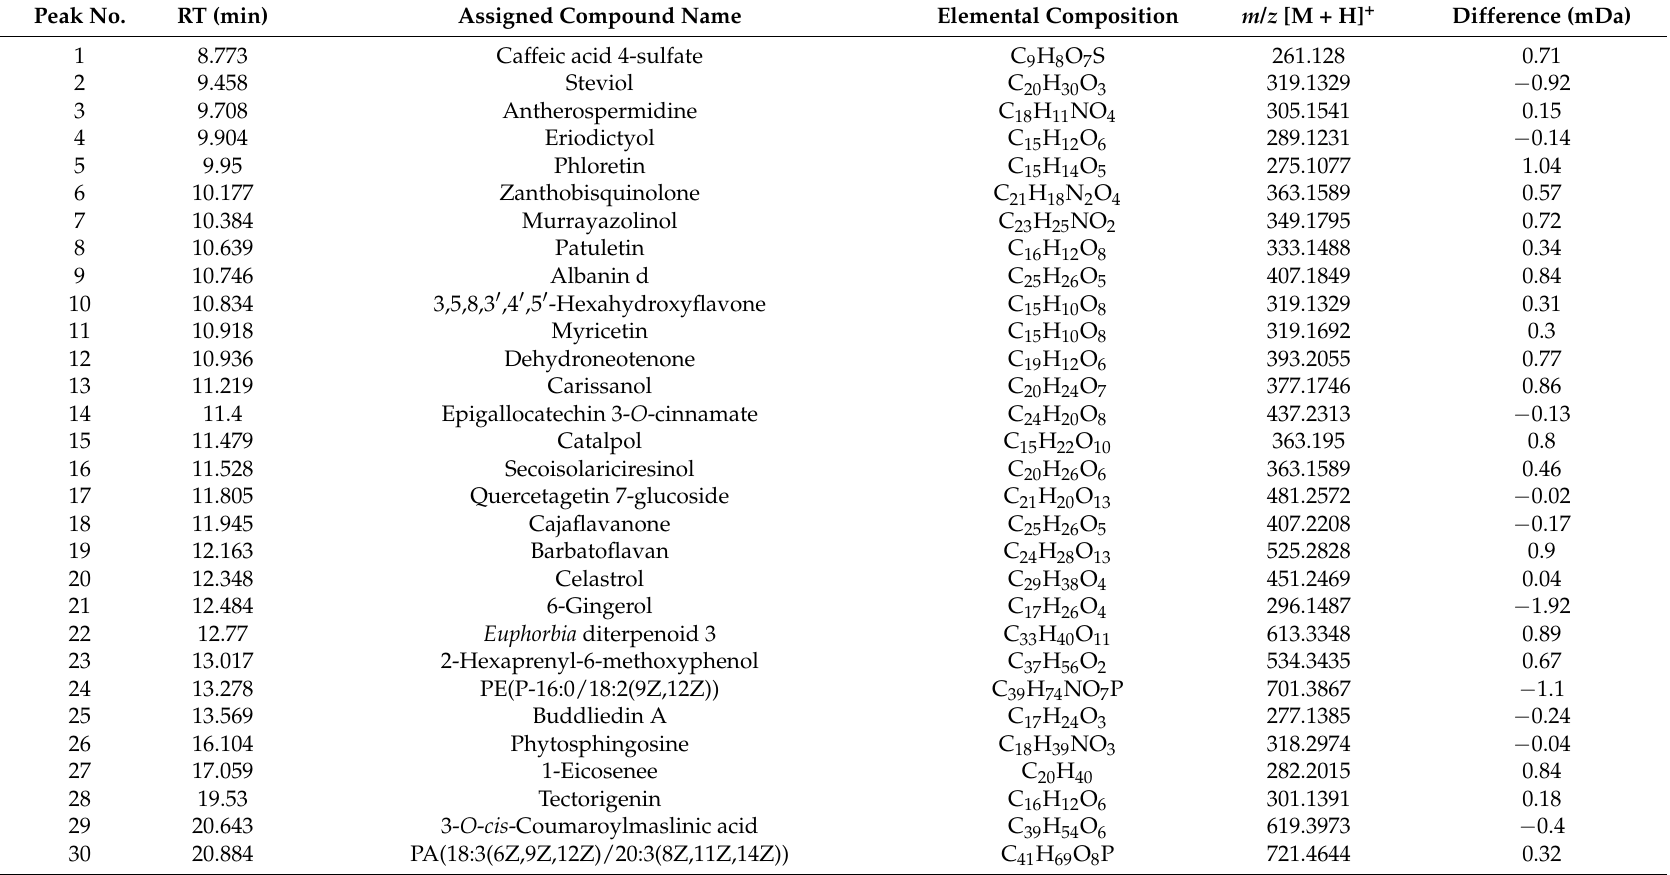
Table 3. Bioactive Compounds identified in Ethanolic Extract of